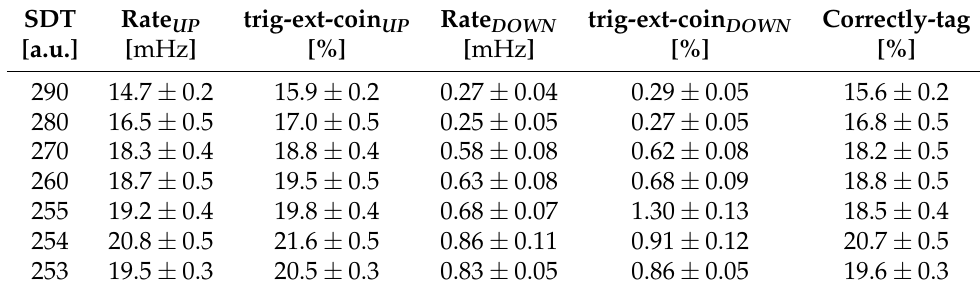
Table 3. As in Table 2, for a charge threshold equal to 65 a.u.